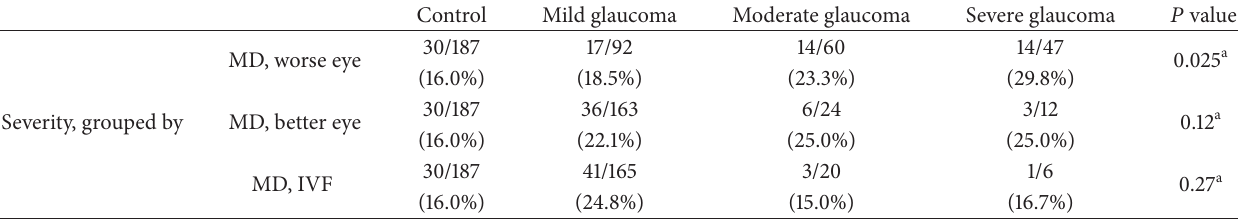
Table 4: Prevalence of MVCs in subjects with POAG, grouped by MD in the better eye, worse eye, or